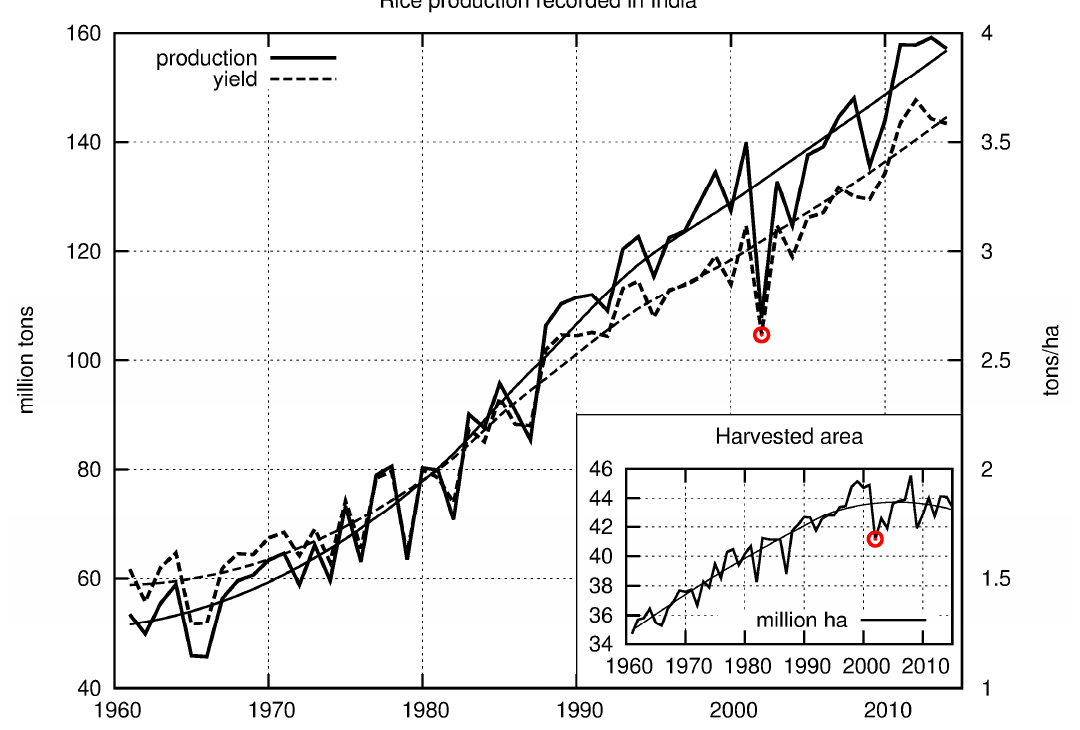
Figure 3. Annual rice production and yield time-series (FAOSTAT data). Smoothed lines represent non-linear fits of the annual data using LOESS [24]. The bottom right inset represents the recorded harvest area time-series. The 2002 anomalies are highlighted with red circles.